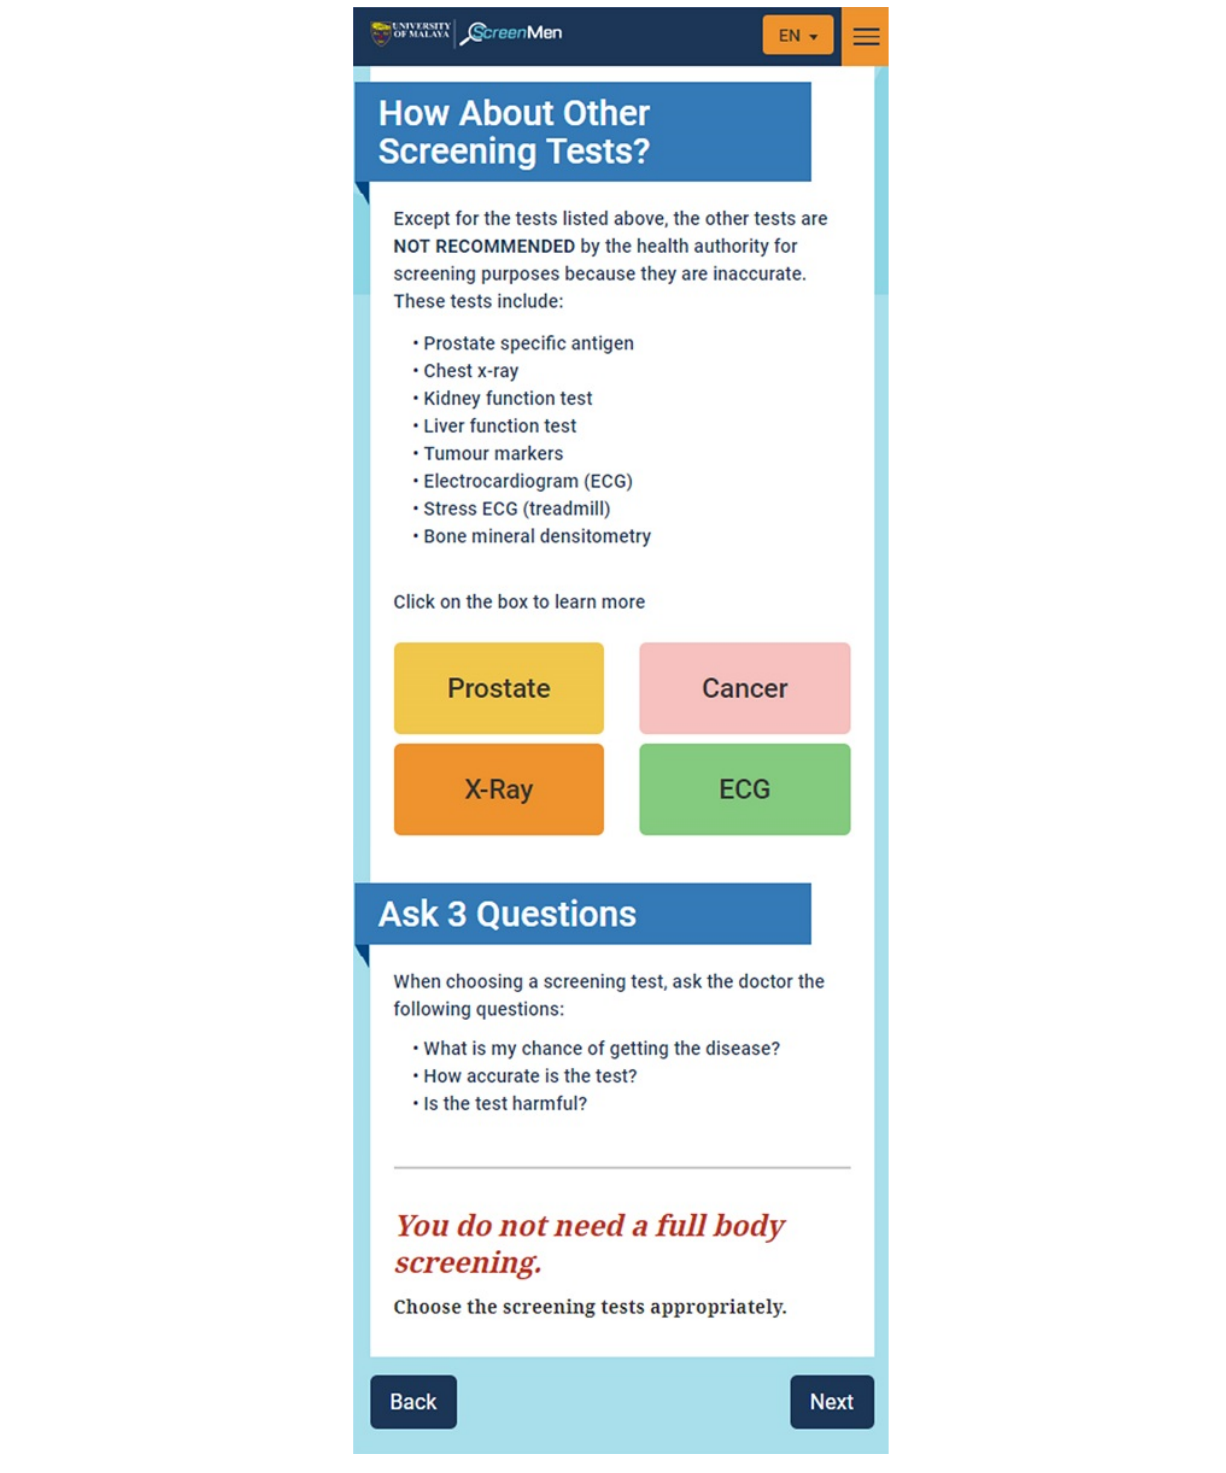
Figure 4. The newly added section to encourage users to avoid unnecessary